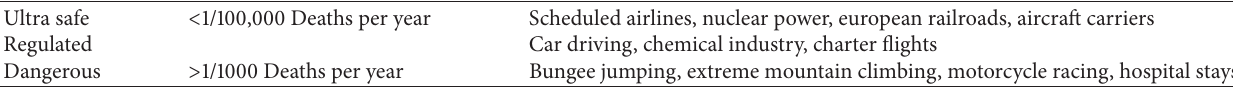
Table 1: Comparison of safety of different human activities